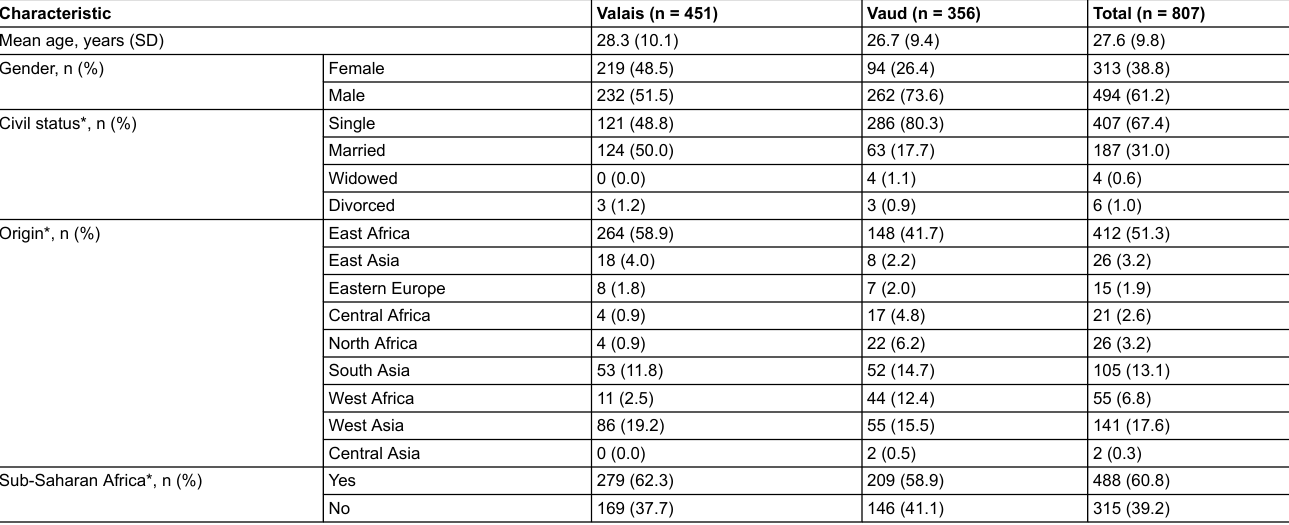
Table 1: Characteristics of the study population. Characteristic